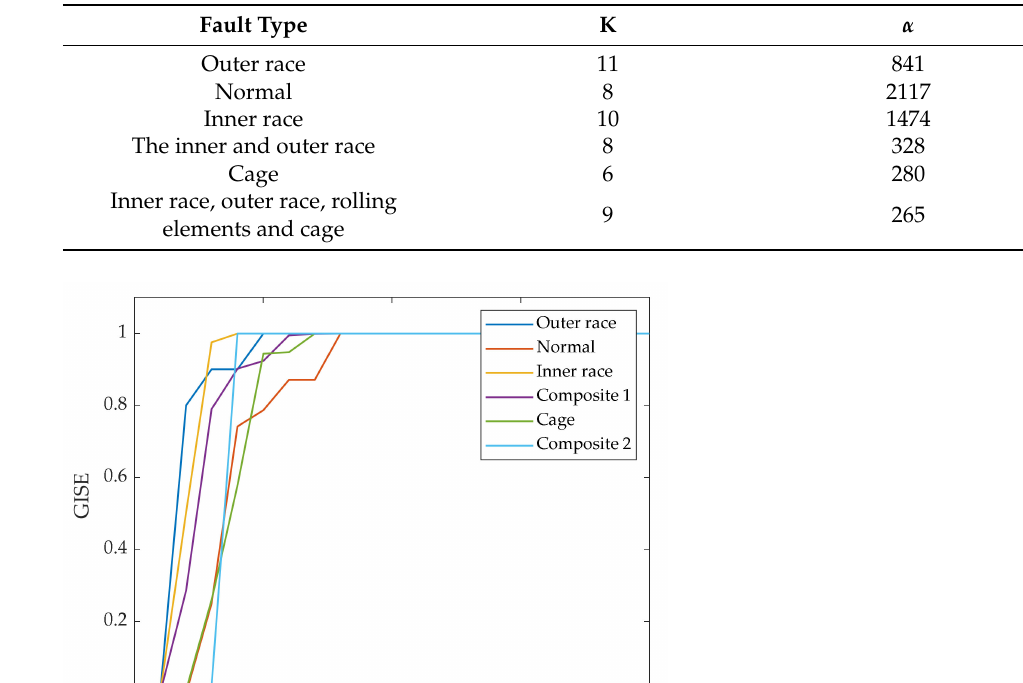
Table 5. Optimal parameters of CHBA-VMD.